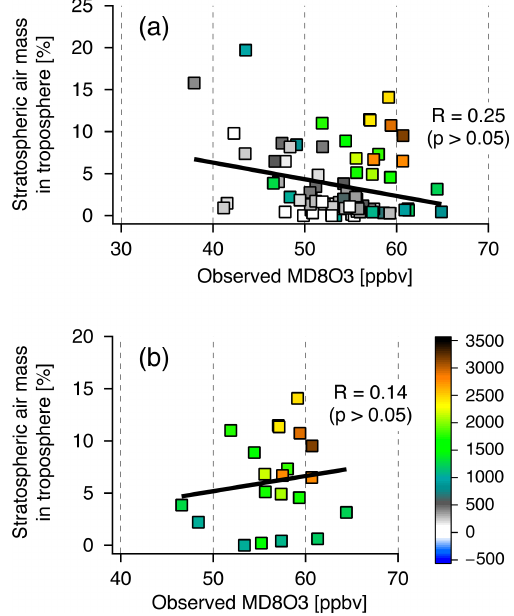
Figure 10. Relationship between observed MD8O3 at the surface and the estimated stratospheric air mass contributed to total tropo- spheric O 3 column as a monthly average during April 2010. The points are color coded based on elevation of each site. (a) All CAST- NET sites (except Alaska) and (b) elevated CASTNET sites defined as having an elevation greater than 1000m (see also Table